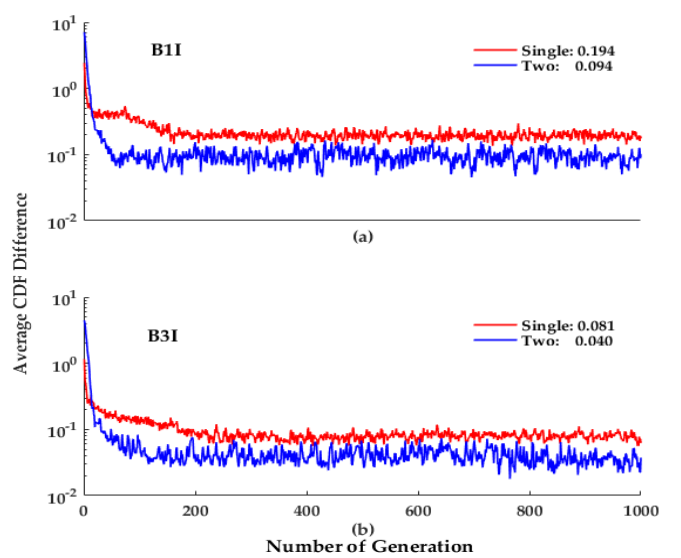
Figure 9. Average CDF difference comparison. The sub-figures ( a , b ) are results of B1I and B3I re- spectively.